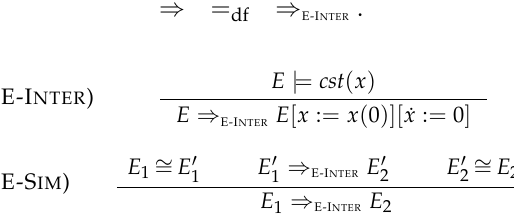
Figure 27. Simplification rules for systems of